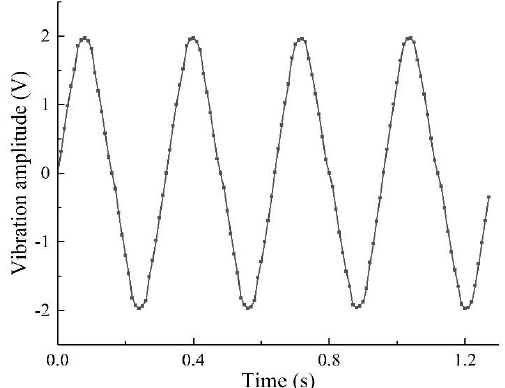
Figure 25. Data received by the computer.